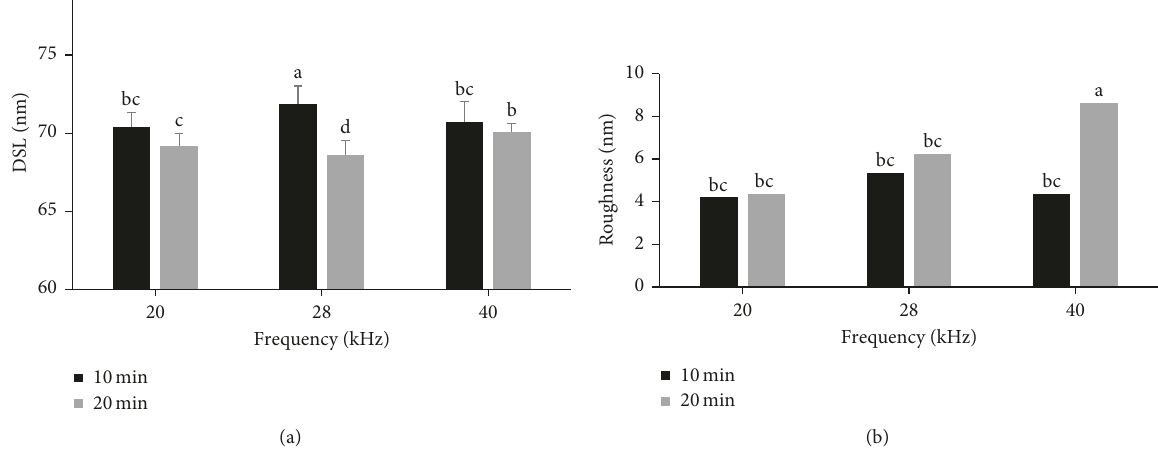
Figure 3: DSL (a) and roughness (b) of collagen fibrils under different ultrasonic frequencies and times. a, b, c, and d values in the row and column; entries with the same superscript are not significantly different ( p ≥ 0 .